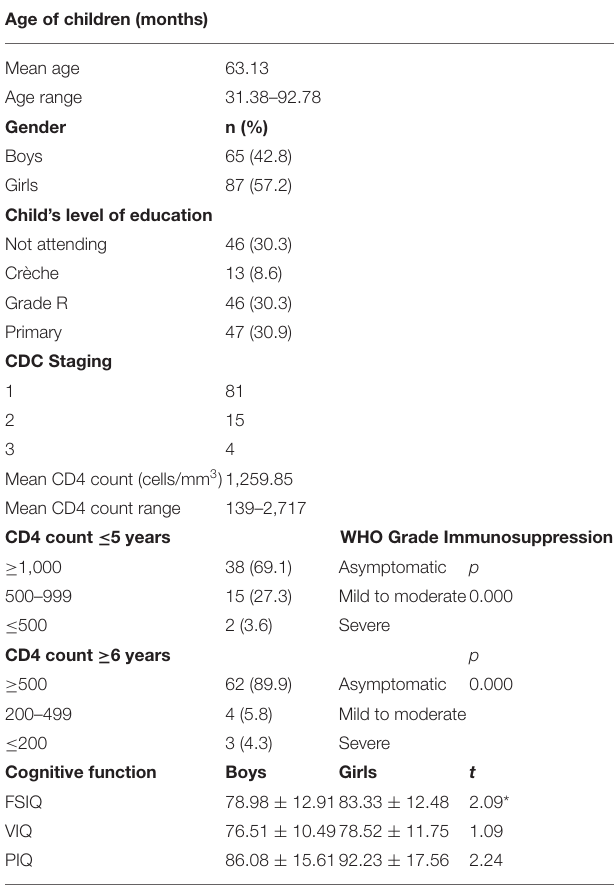
TABLE 2 | Sociodemographic, clinicoimmunological, and cognitive characteristics of the HIV-positive children ( N = 152) in the study. Age of children